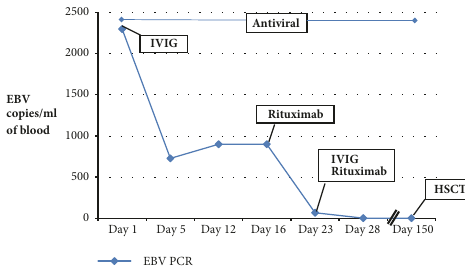
Figure 2: EBV copies remained at nearly 1000 per mL in peripheral blood after a 2-week treatment combination of IVIG and antivirals. EBV copies were reduced drastically with the first dose of rituximab and became undetectable following the second